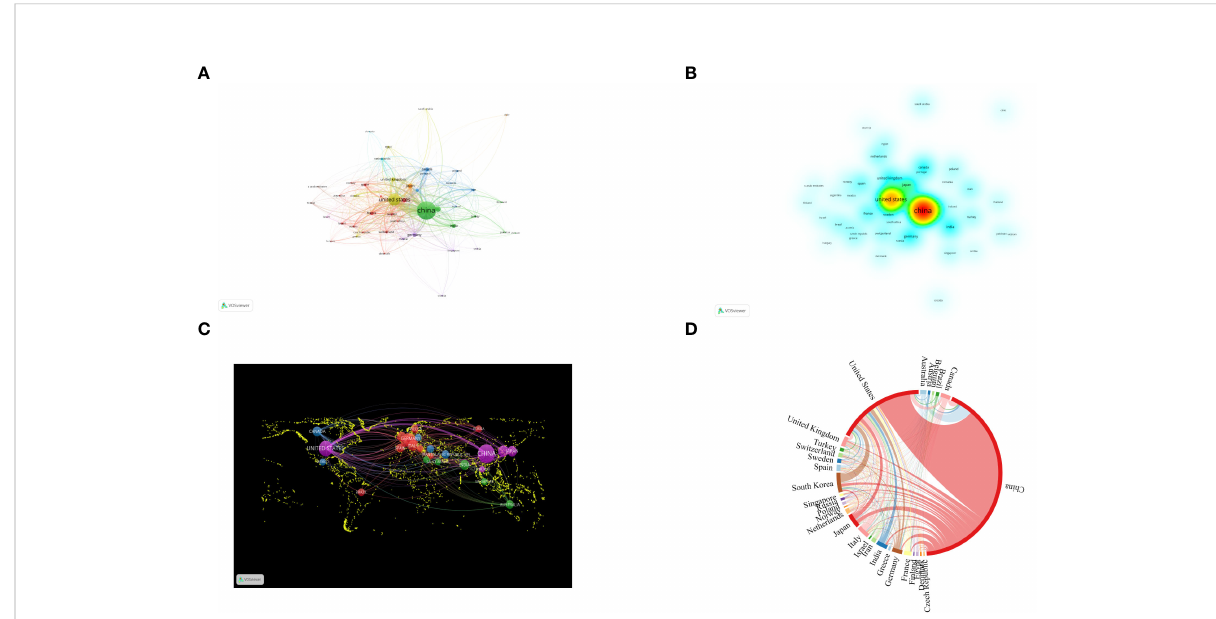
FIGURE 3 Contributions of various countries to the research of autophagy in lung diseases. (A) Country collaboration map of autophagy research in lung disease. Circles denote countries, and lines denote their collaborations. (B) Countries ’ density map. (C) World map of countries ’ cooperation density. (D) A circle diagram evaluating the international collaboration between